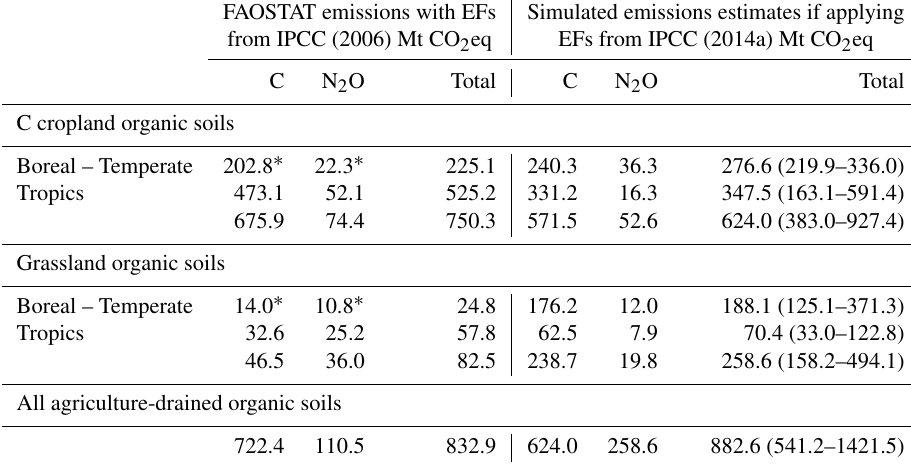
Table A3. Comparison of our emission estimates by land use and gas generated applying the EFs from the 2006 Guidelines (IPCC, 2006) with emissions estimates if ceteris paribus the EFs from the Wetlands Supplement (IPCC, 2014a) were applied instead to the